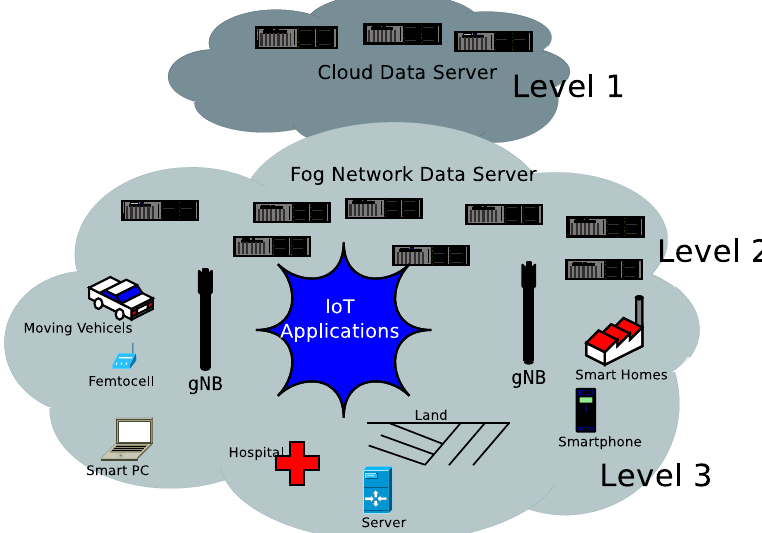
Figure 1. The 5G-based fog network architecture, it has three layers of independent working model to support the heterogeneous networks